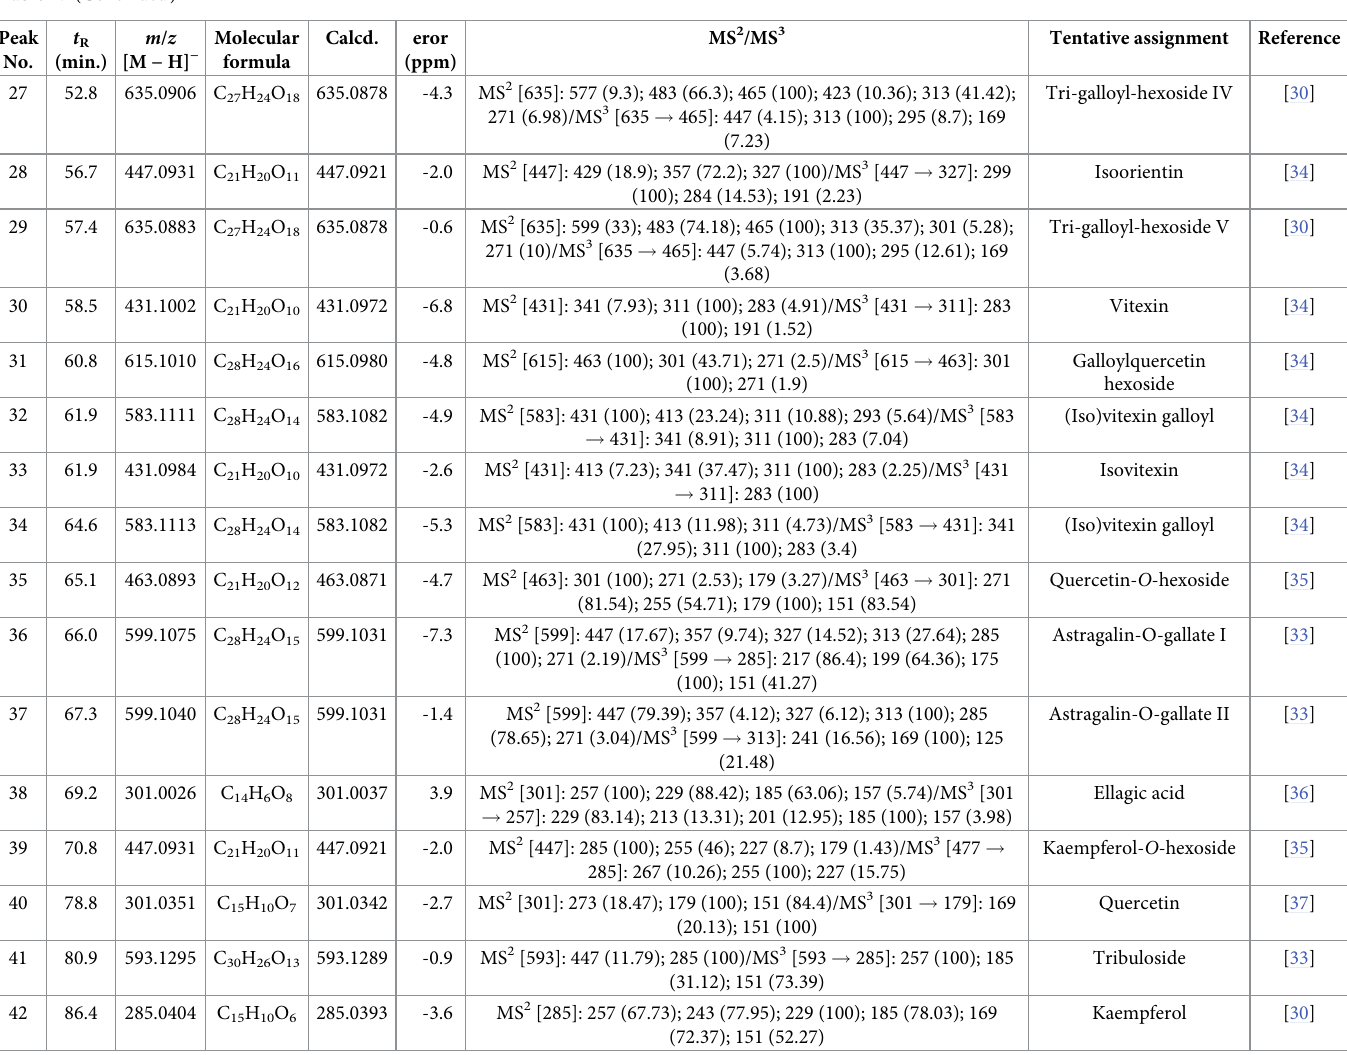
antinociceptive properties. A phase-reverse chromatography of the fraction was performed, allowing isolation of gallic acid (GA), methyl gallate (MG) and 1,2,6-tri-O-galloyl- β - D -gluco- pyranose (TGG). GA at 12.5 ( p < 0.01), 50 ( p < 0.001) and 200 ( p < 0.001) mg/kg, adminis- tered by intraperitoneal route 40 min before formalin injection, reduced the nociceptive behavior of mice in late, but not early phase of the test (Fig 4). GA at 3.12 and 0.78 mg/kg did not induce effect on formalin test. Pretreatment with indomethacin (10 mg/kg, ip), a standard nonsteroidal anti-inflammatory drug, produced a similar inhibition profile of late phase ( p < 0.001). As expected, the pretreatment with morphine (5 mg/kg, ip), a gold standard opi- oid, inhibited both the early ( p < 0.01) and late ( p < 0.001) phase of the formalin test. Intraperitoneal administration of MG (3.1–200 mg/kg), 40 min before formalin injection, inhibited the late phase of formalin test ( p < 0.001; p < 0.01; p < 0.05). MG at 0.78 and